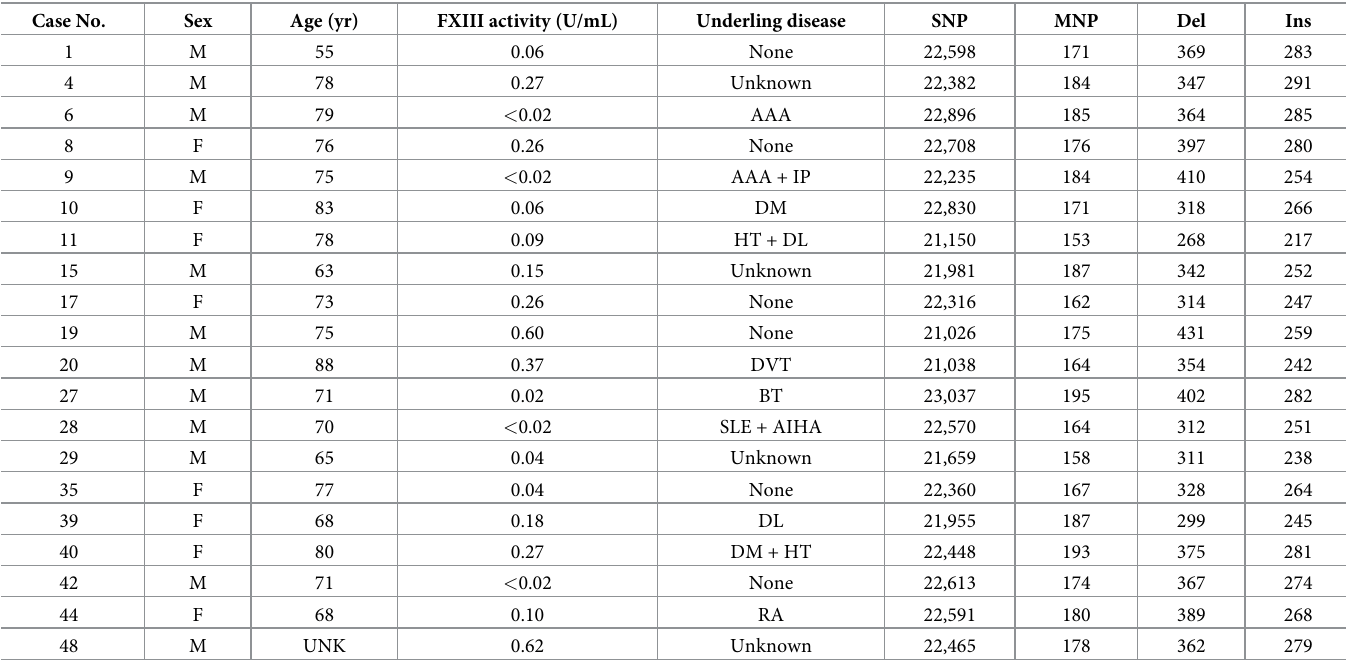
Table 1. Summary of variants in 20 autoimmune FXIII deficiency cases. Case